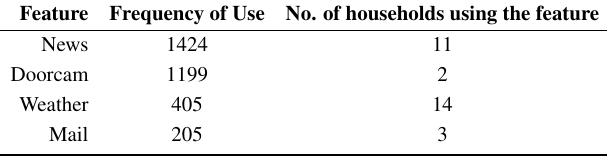
Table 6. Usage frequency of the features accessible over the informative art GUI on the central unit.